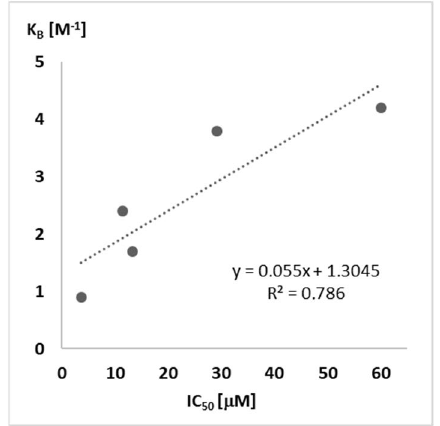
Figure 3. Relationship of the inhibition concentration IC 50 and the binding constant K B . The binding constant K B × 10 5 of the intercalation between ureas 11j – 11n and ct DNA is given as a molar concentration. The value of the inhibition concentration IC 50 of ureas 11j – 11n against HeLa cancer cell lines is given as a micromolar concentration.